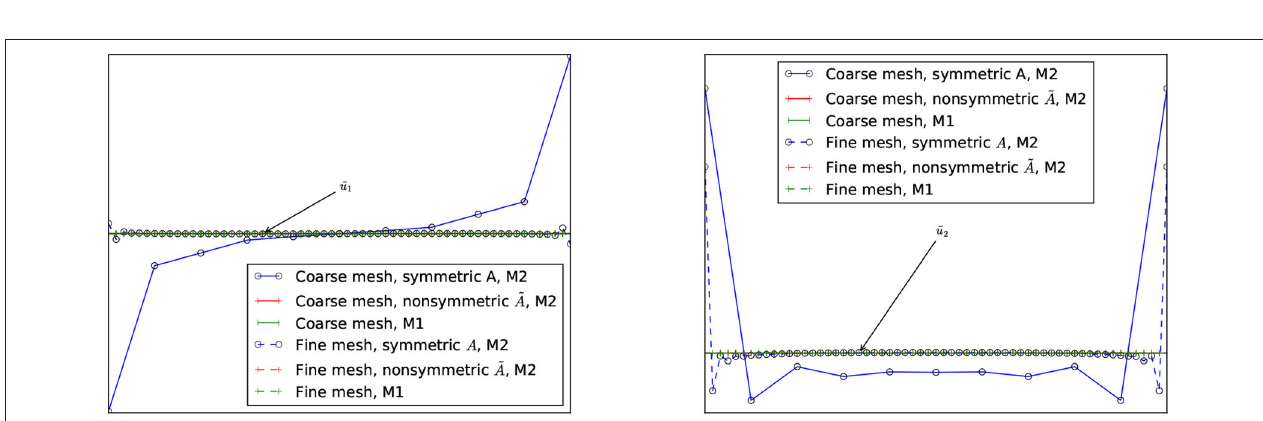
FIGURE 8 | Numerical results along the contact zone, for the trivial contact problem whose solution is a vertical rigid body translation. Left : Horizontal displacements, ˜ u 1 represents the exact zero horizontal displacement. Right : Vertical displacements, ˜ u 2 represents the exact vertical displacement.